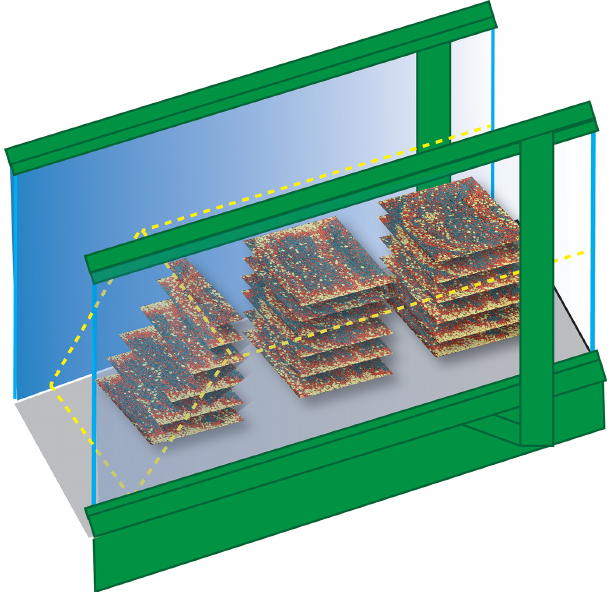
Figure 8. Application of the image analysis technique to stratig- raphy measurements. Schematic of size stratification of a deposit evaluated with image analysis.